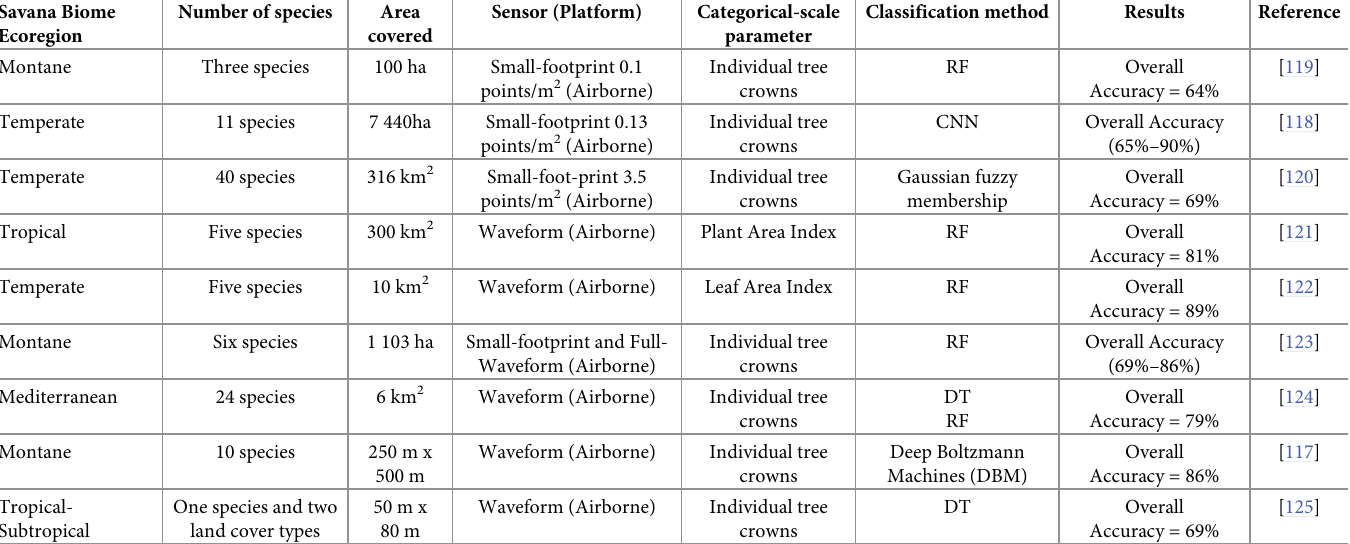
Table 3. Examples of studies which categorically classified woody plant species in savanna using LiDAR remote sensing. Savana Biome